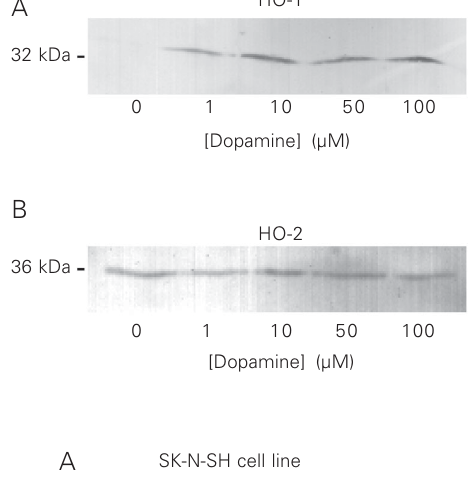
Figure 3. Effect of selegiline on the levels of HO-1 mRNA in the SK-N-SH cell line exposed to dopamine for 24 h. A : Northern blot analysis. B : Relative expres- sion levels of HO-1 mRNA. Data are reported as means ± SEM (N = 5). DA = dopamine *P < 0.05 and **P < 0.01 compared with 0 µM selegiline at 10 µM or 100 µM dopamine (two-way ANOVA